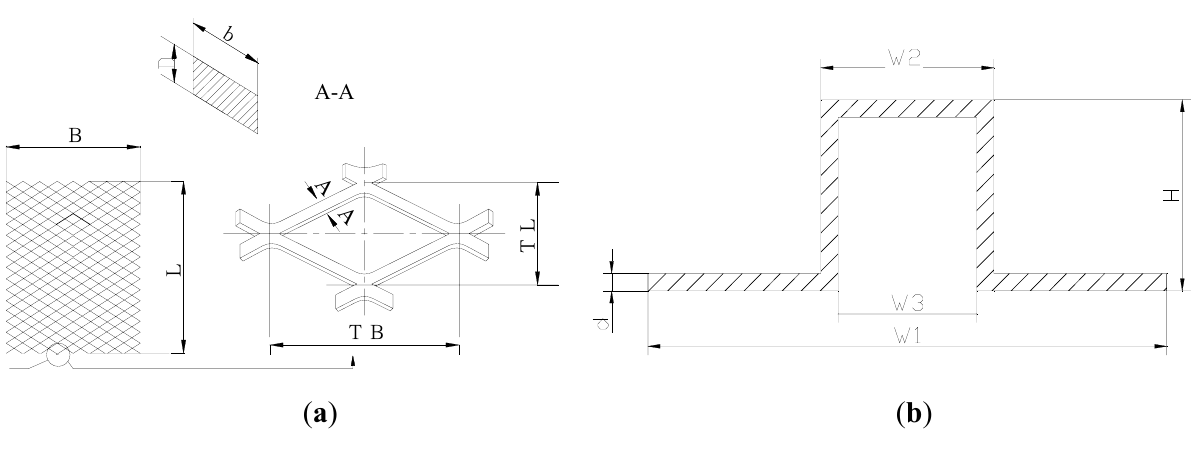
Figure 5. The structure of the aluminum mesh plate and profiled strip. ( a ) Aluminum mesh plate; ( b ) Profiled